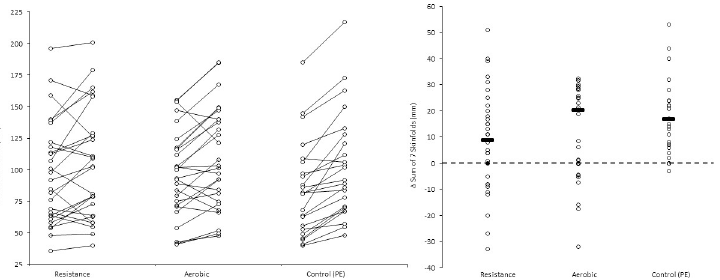
Fig 2. Left panel: Sum of skinfold difference (mm) pre- and post- intervention for each participant, and group means. Right panel: Individual participant and mean within-group post-intervention sum of skinfold difference (mm). Pairwise effect sizes for within-group difference: Resistance; d = 0.25, aerobic; d = 0.40, PE (control); d = 0.58.